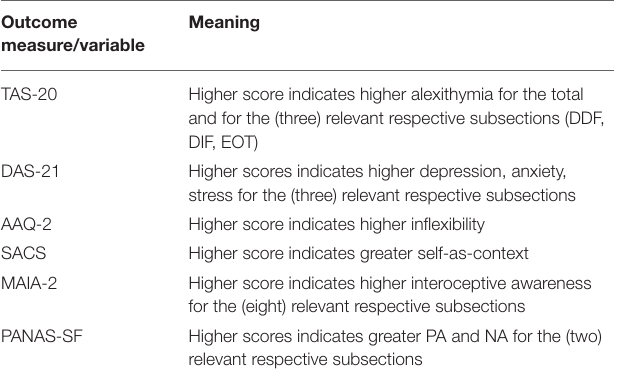
regressed against the DV (alexithymia total). For this, adjusted 0.001]. The same predictors were used for all of the regression model. For the second regression (see Table 5 ), the DV was